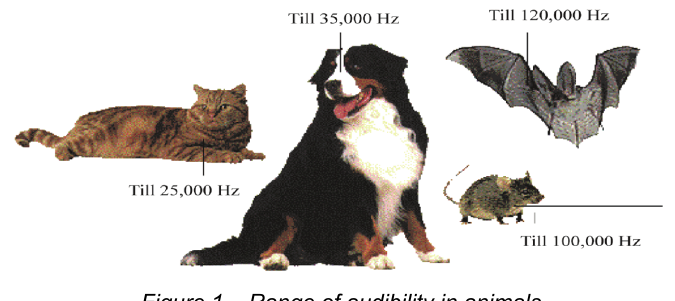
Figure 1 – Range of audibility in animals Рис . 1 – Диапазон слышимости животных Слика 1– Спектар чујности код животиња (http://www.znanje.org/i/i25/05iv08/05iv080911fll/zvuk.htm,